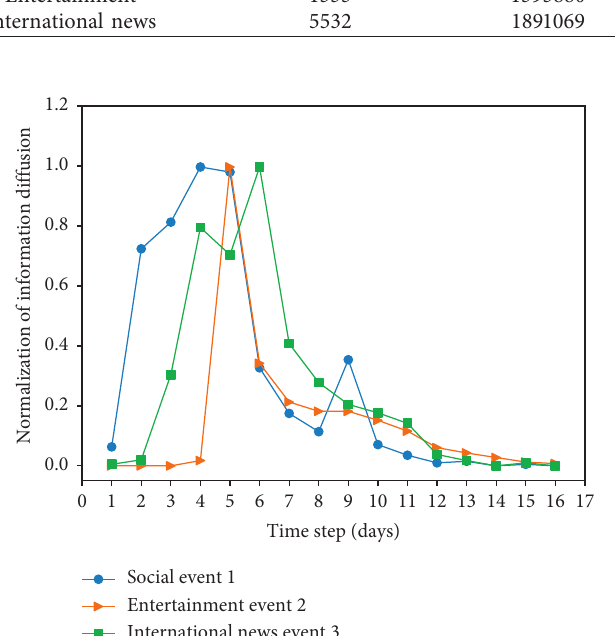
Figure 4: Trends for the development of the three Weibo hot events. The social event is more likely to receive social attention according to an earlier increase of forwarding behaviors, followed by entertainment and international news.